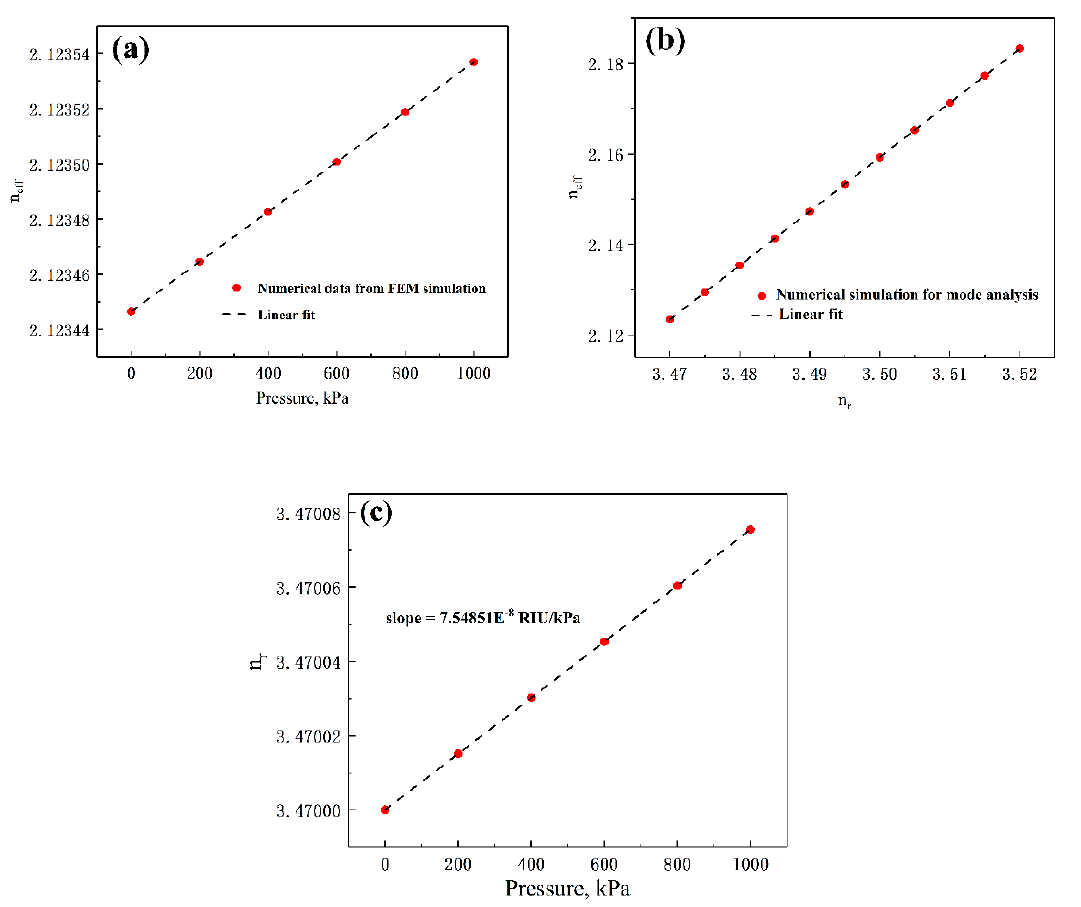
Figure 9. ( a ) The variation of n eff versus the applied pressure. ( b ) The relationship between the n eff and n r of MDR. ( c ) Increment of RI in Si resonator versus the applied pressure.